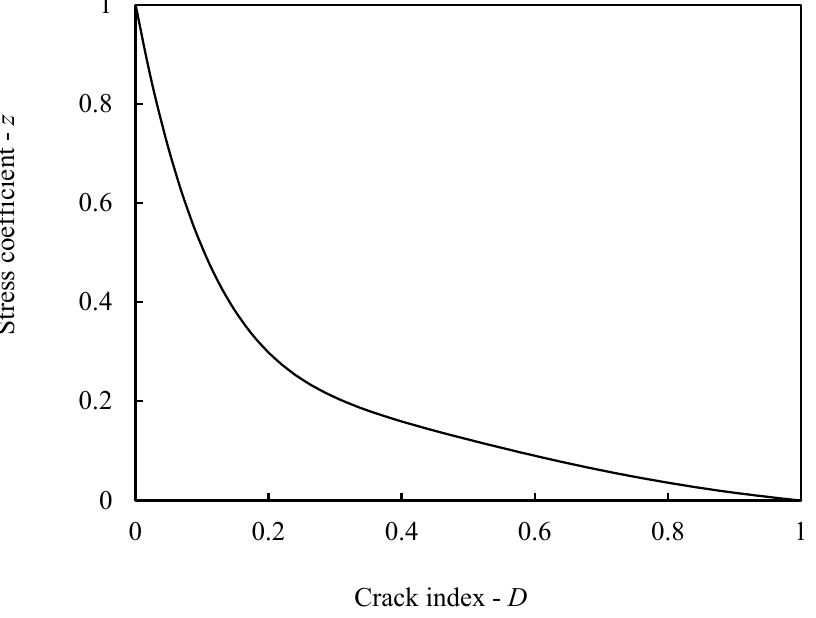
Figure 4. Normalized strain softening curve.